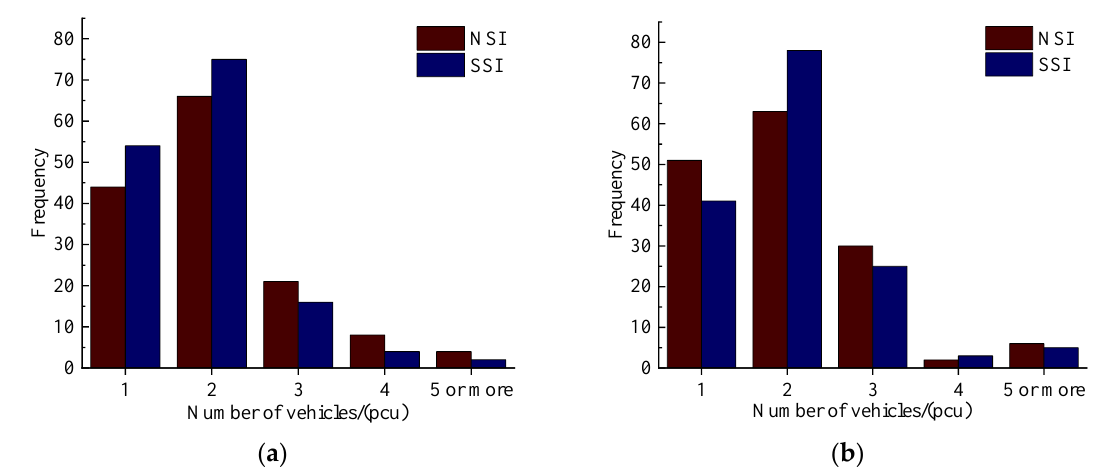
Figure 7. ( a ) Number of vehicles in Section Ⅰ ; ( b ) Number of vehicles in Section Ⅱ . Finally, the difference between serious accidents and non-serious accidents is analyzed. According to existing studies [33,34], this paper considers fatal accidents and accidents with severe injuries as serious accidents, and minor injury accidents and property loss accidents are viewed as non-serious accidents. The statistical results are shown in Figure 8.